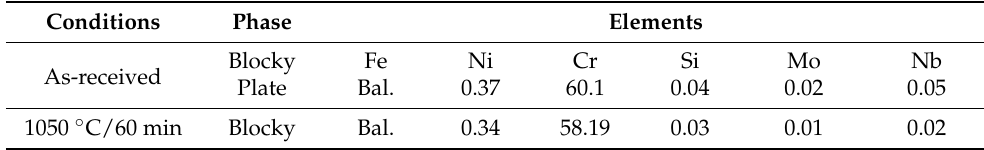
Table 3. Chemical composition of sigma phase at different conditions